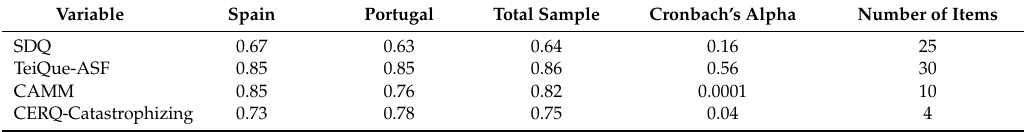
Table 1. Estimates of reliability and comparison of Cronbach’s alpha coe ffi